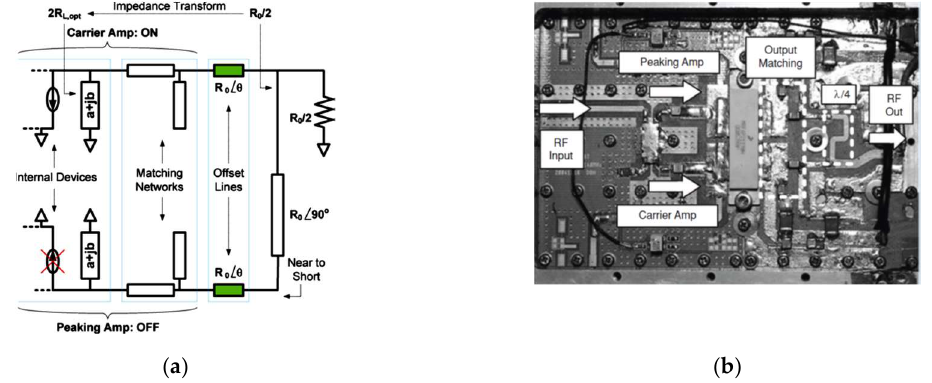
Figure 8. ( a ) Load network of inverted DPA operation [57], ( b ) Picture of the 190W IDPA described